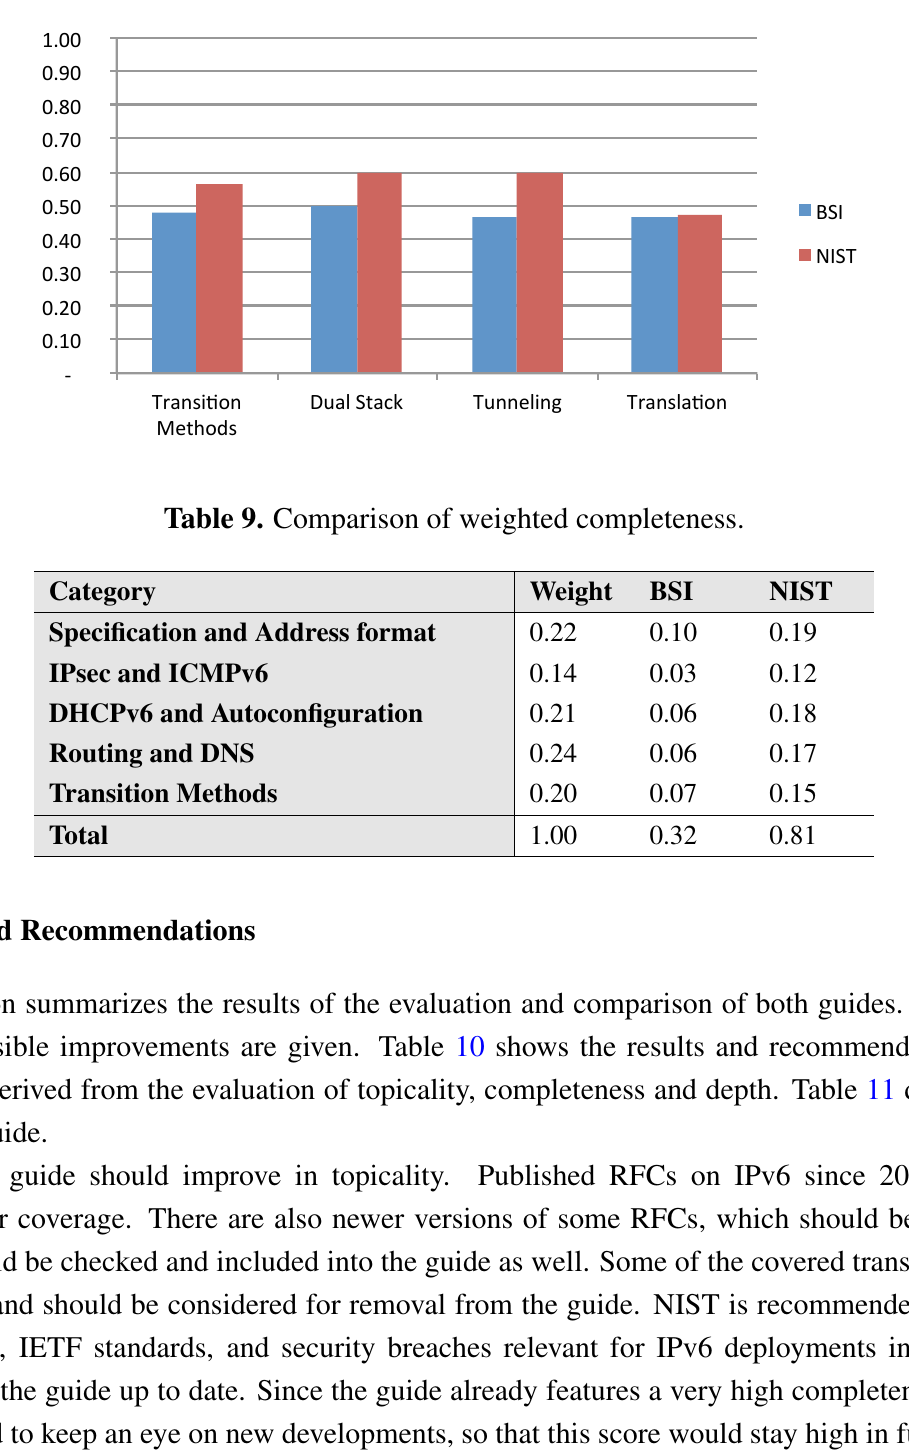
Figure 13. Average depth of transition methods.